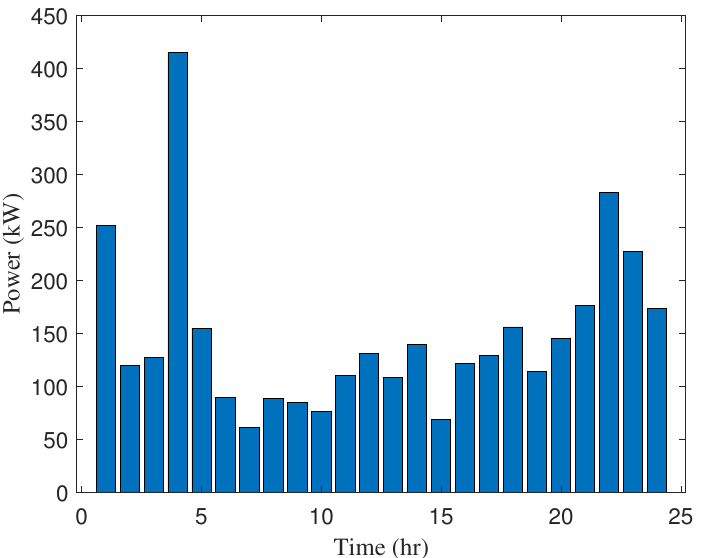
Figure 12. Optimal demand − response schedule considering peak load reduction and user comfort.